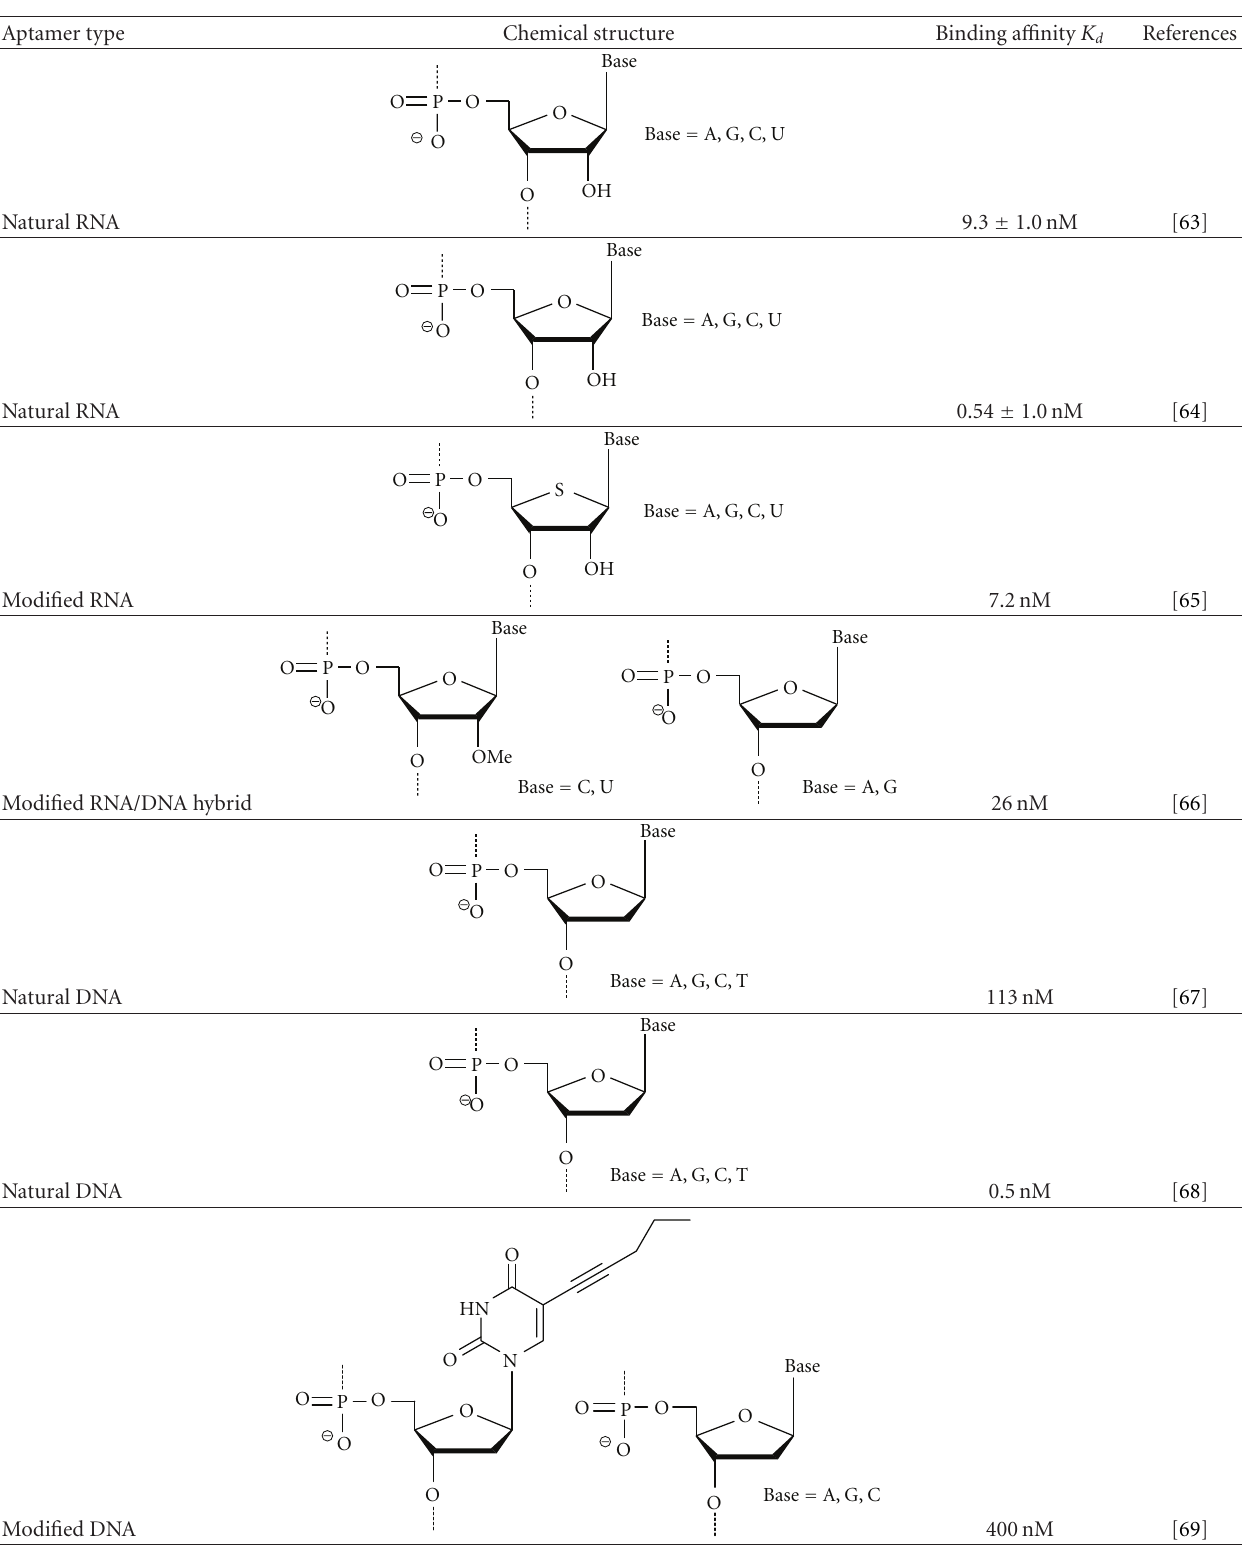
Table 2: Comparison of binding a ffi nities in thrombin-binding natural/modified nucleic acid